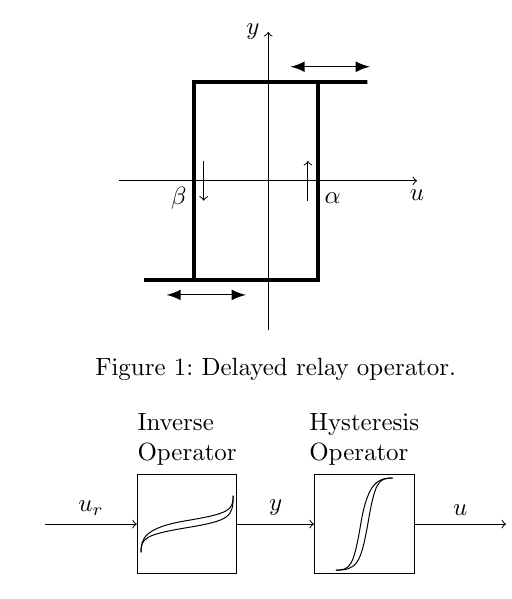
Figure 2: Illustration of feed forward hysteresis com-